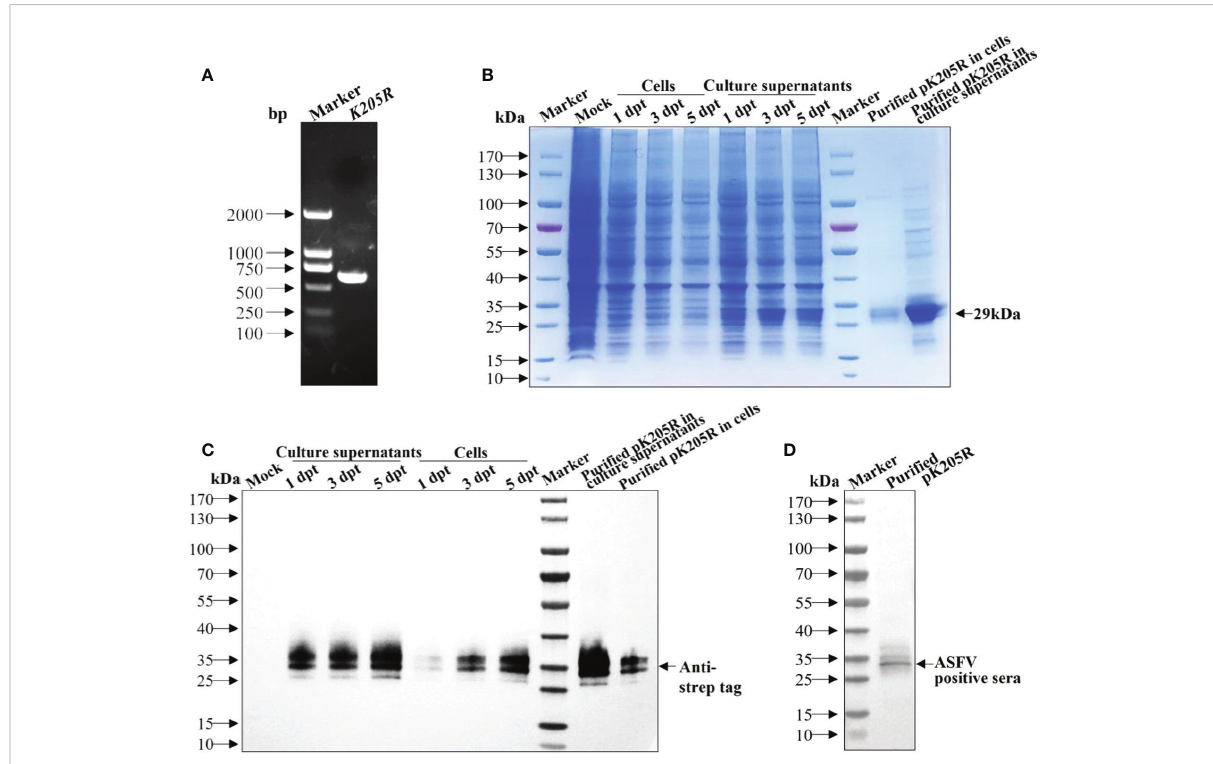
FIGURE 1 The recombinant pK205R was successfully expressed in 293i cells. (A) PCR ampli fi cation of K205R gene. (B, C) Identi fi cation of pK205R expression and puri fi cation in the culture supernatants and ultrasonic cells by SDS-PAGE (B) and WB (C) . (D) Identi fi cation of puri fi ed pK205R by WB using an ASFV-positive serum as primary